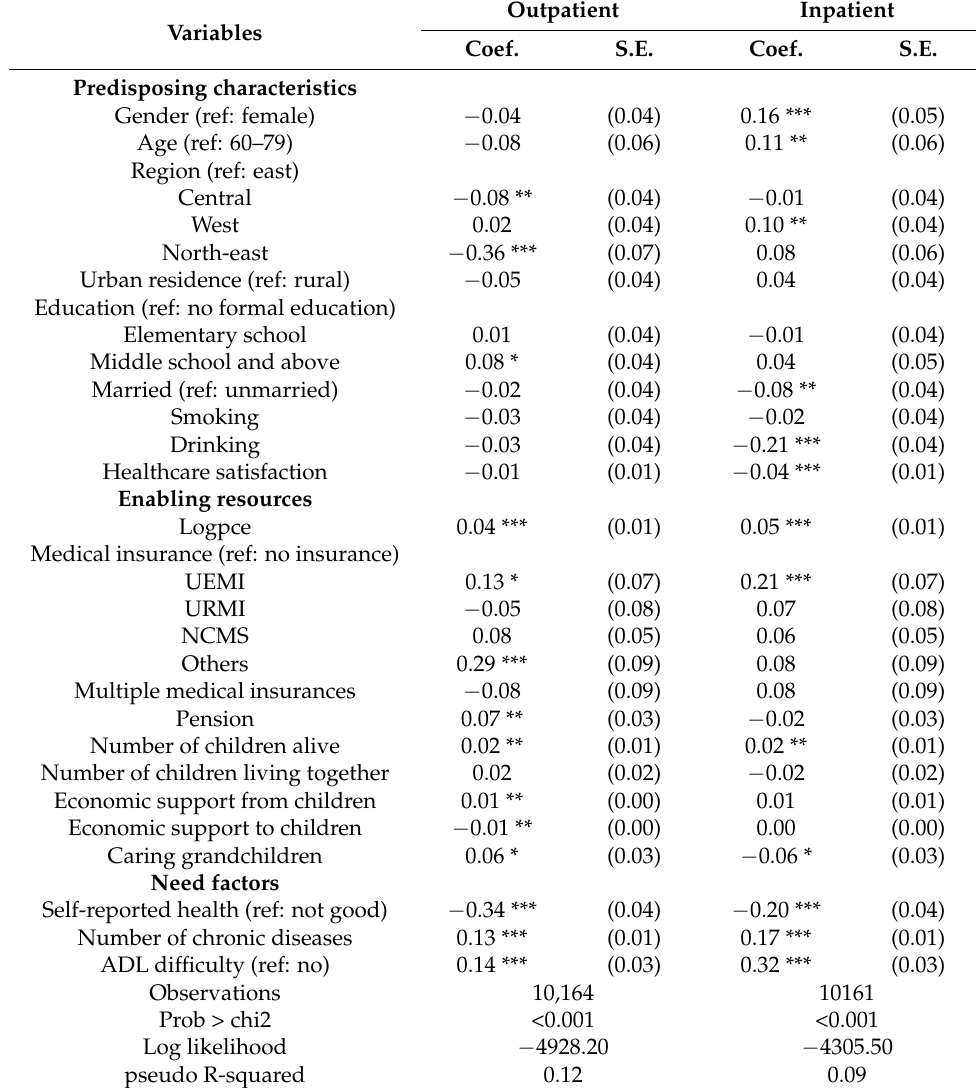
Table 3. Results of the probit regression model on the determinants of healthcare utilization. Outpatient Inpatient Variables Coef. S.E. Coef.